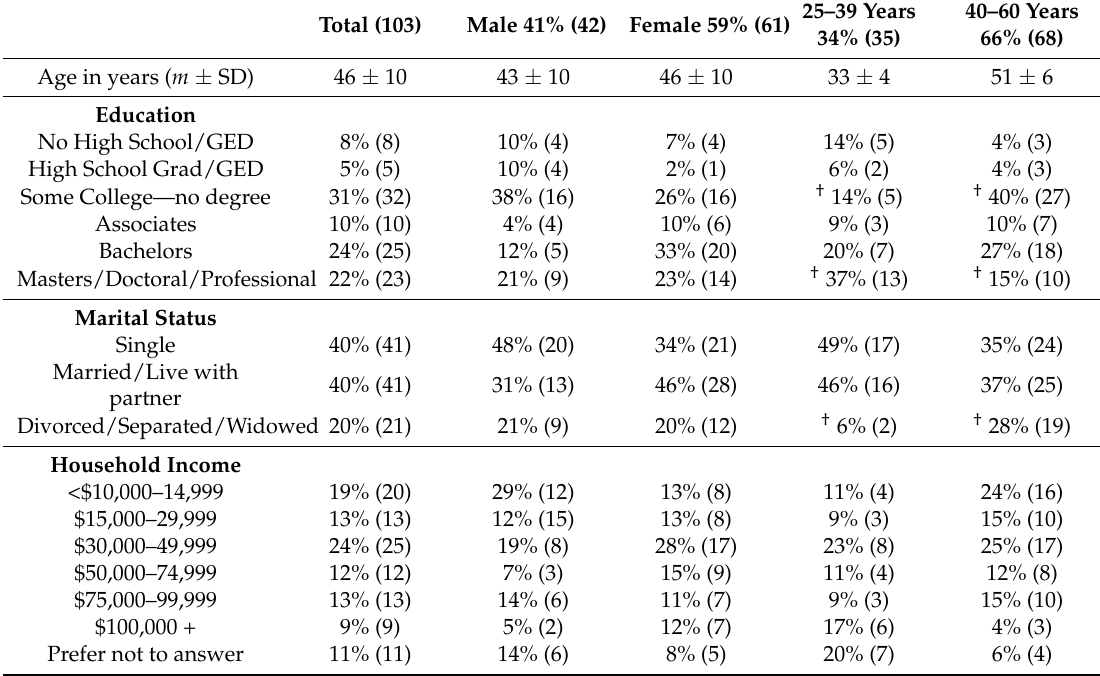
Table 1. Distribution of demographic characteristics of Arizona African American focus group participants by gender and age group [ n = 103; m ± SD; % ( n